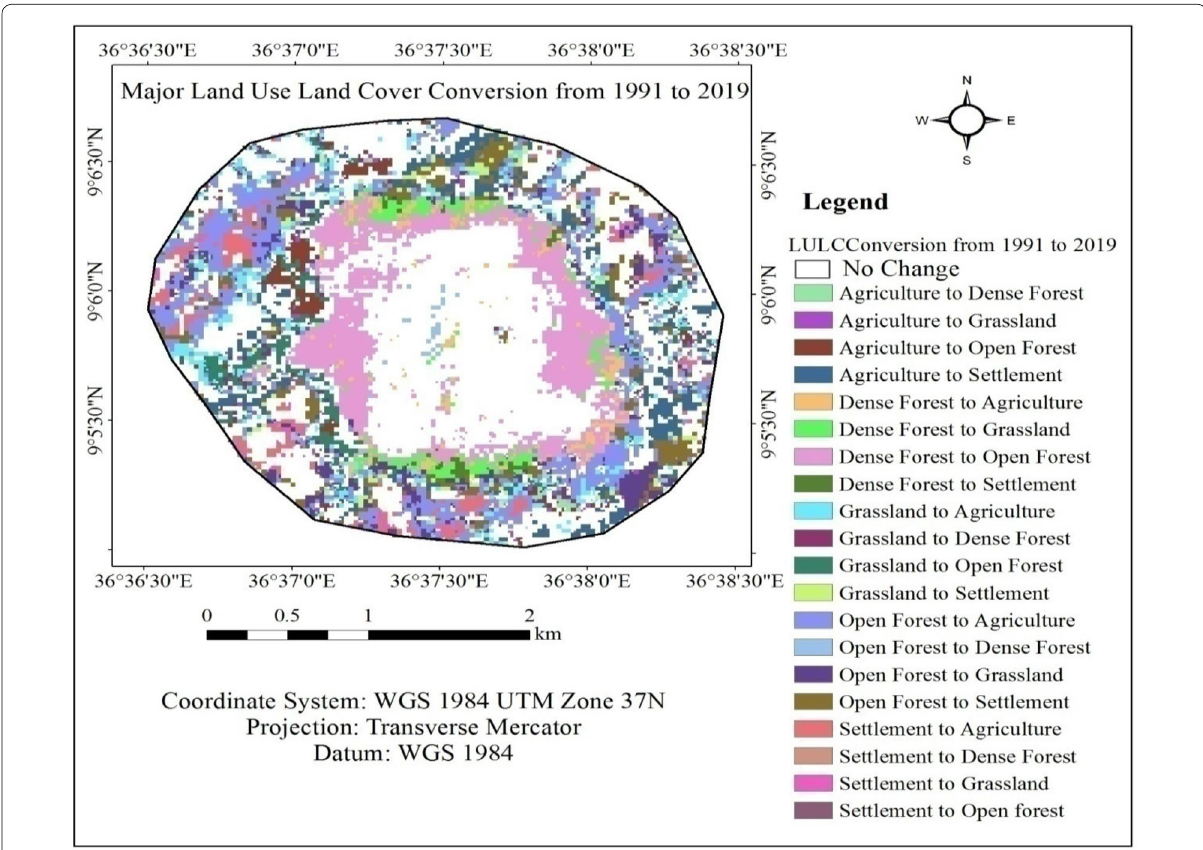
Fig. 5 Major LULC conversion from 1991 to